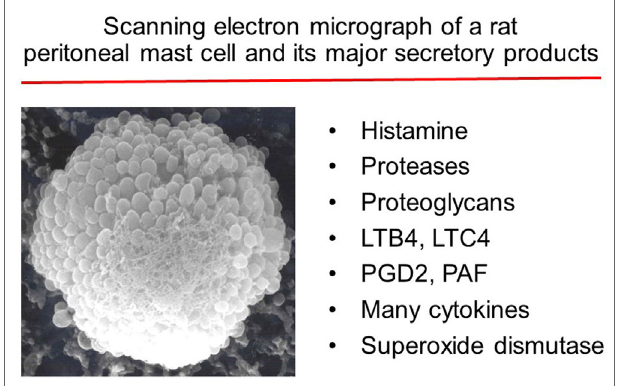
FiGURe 1 | Major substances released by activated mast cells